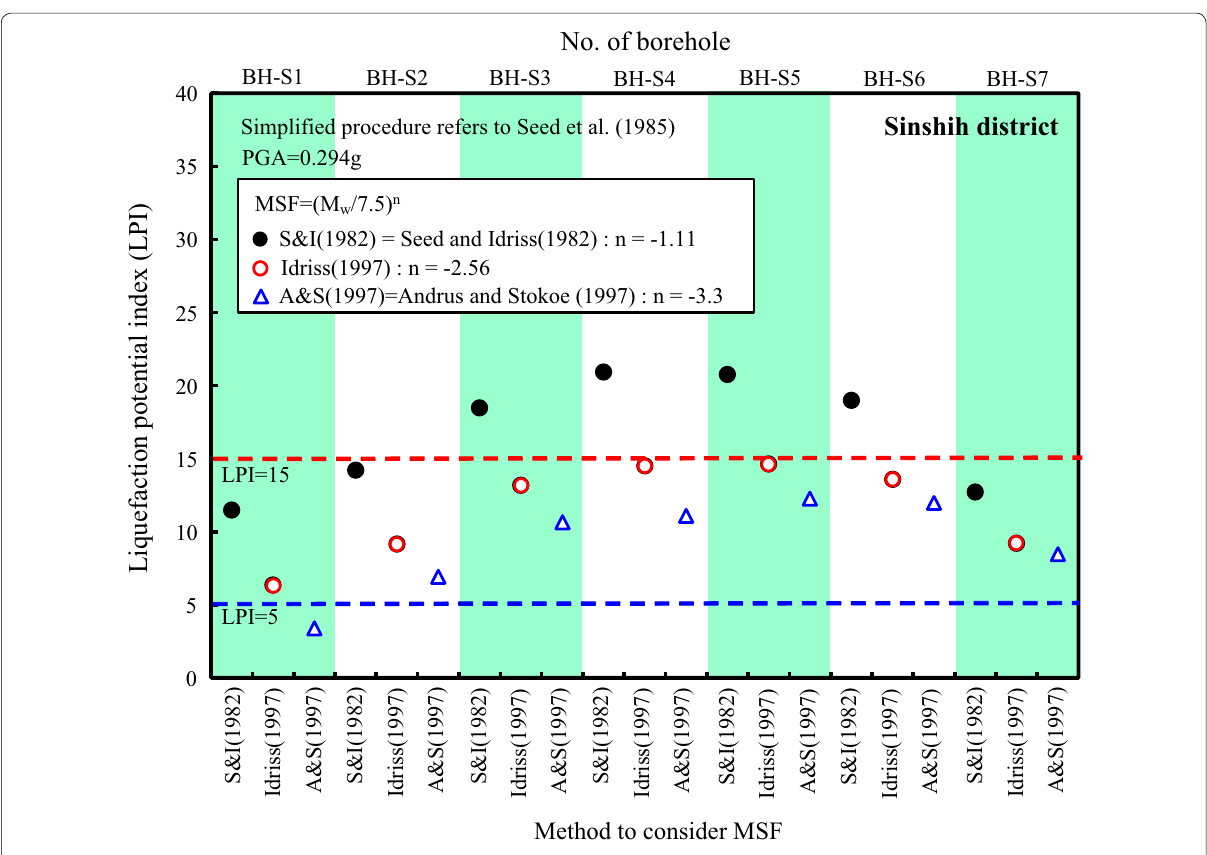
Fig. 8 Evaluated LPIs for the Sinshih District with considering different